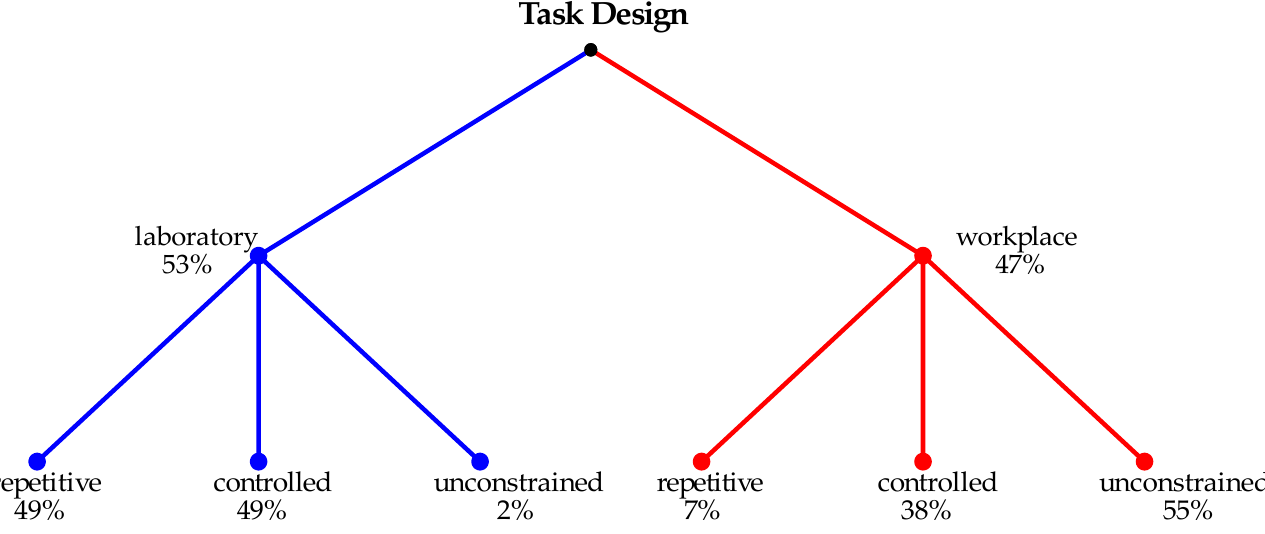
Figure 10. Percentage of the task design for the laboratory setting ( on the left ) and for the workplace setting ( on the right ).